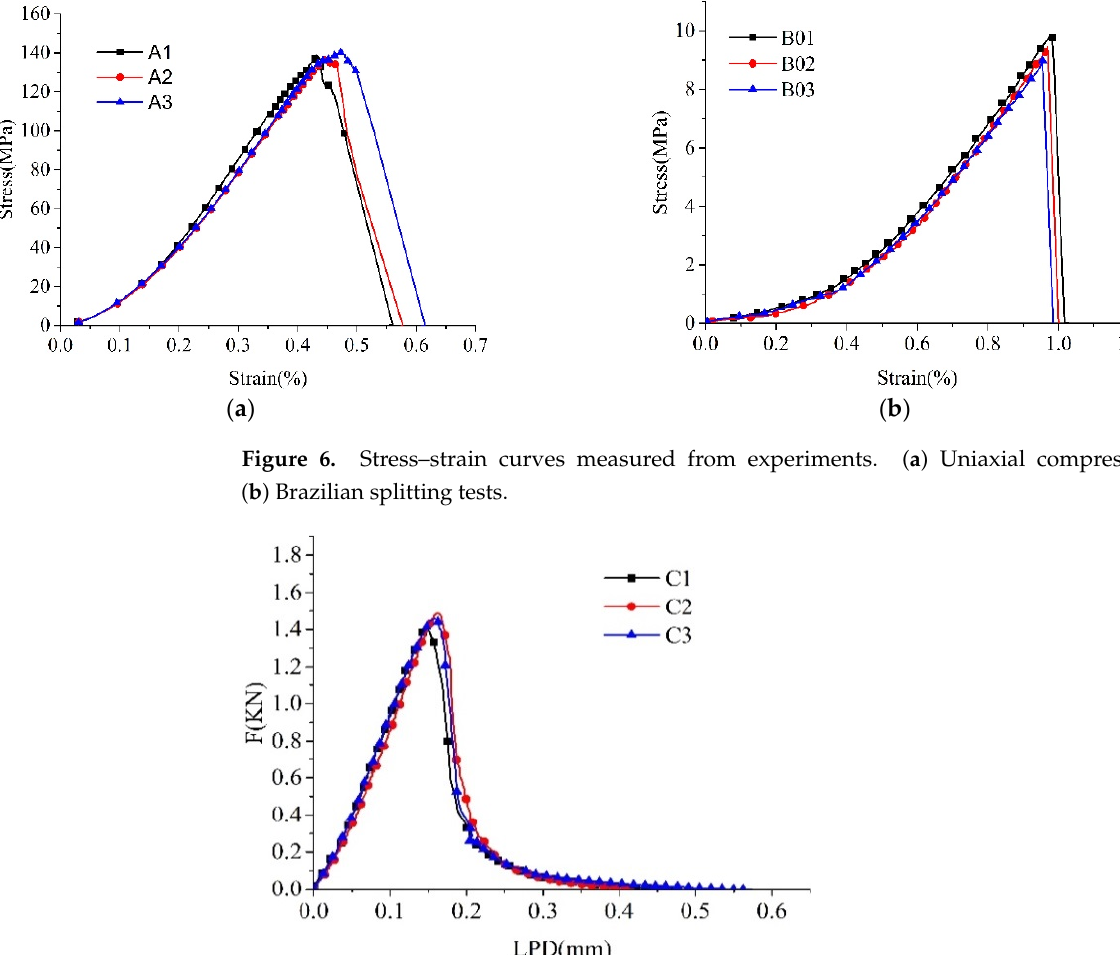
6 of 17 Figure 4. Brazilian splitting experimental device. ( a ) ( b ) Figure 5. Three-point bending experiment information. ( a ) Schematic diagram; ( b ) Specific device. The measured results from the three different kinds of experiments were given in Figures 6 and 7. From these figures, it can be seen that the experimental measured data have a good reproducibility and the results have a fine reliability. Then, through the pro-